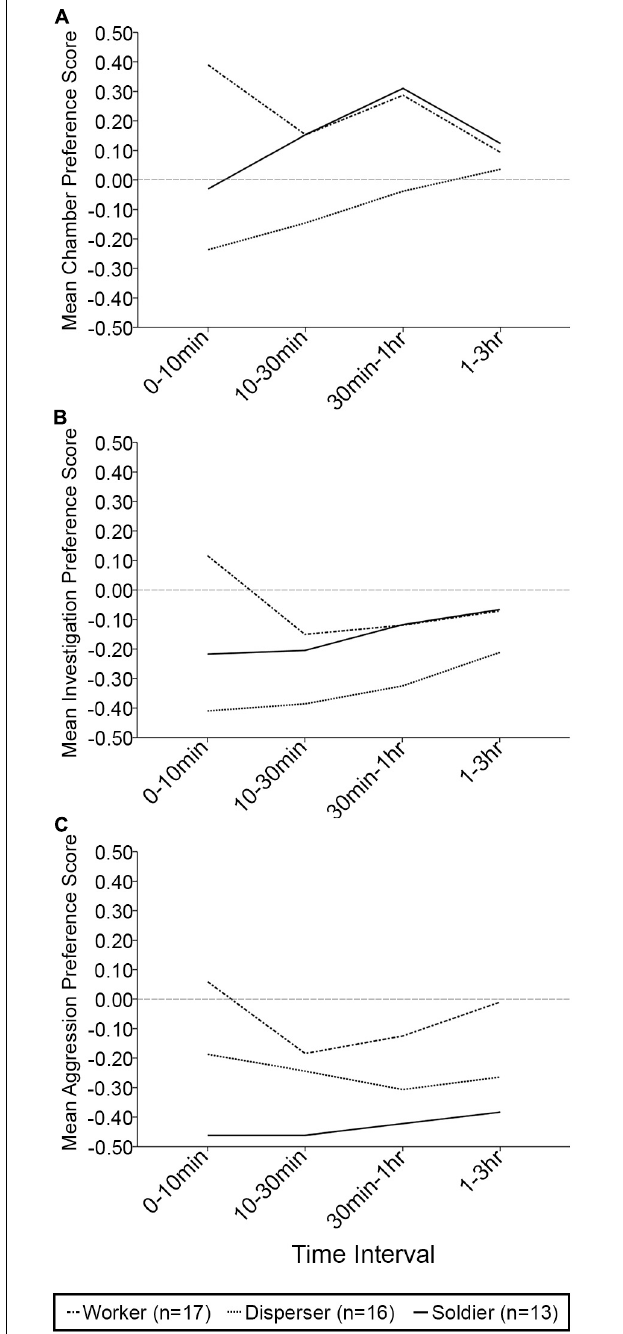
FIGURE 2 | Mean chamber, investigative, and aggressive preference scores over four time intervals in the partner preference test. (A) Mean chamber preference score (positive score indicates preference for time spent in the familiar animal’s chamber). No significant differences were found. (B) Mean investigation preference score (positive score indicates preference for time spent investigating the familiar animal). No significant differences were found. (C) Mean aggression preference score (positive score indicates preference for time spent being aggressive toward the familiar animal). No significant differences were found. n = 17 workers; n = 16 dispersers; n = 13 soldiers and only includes individuals who completed the full 3 h